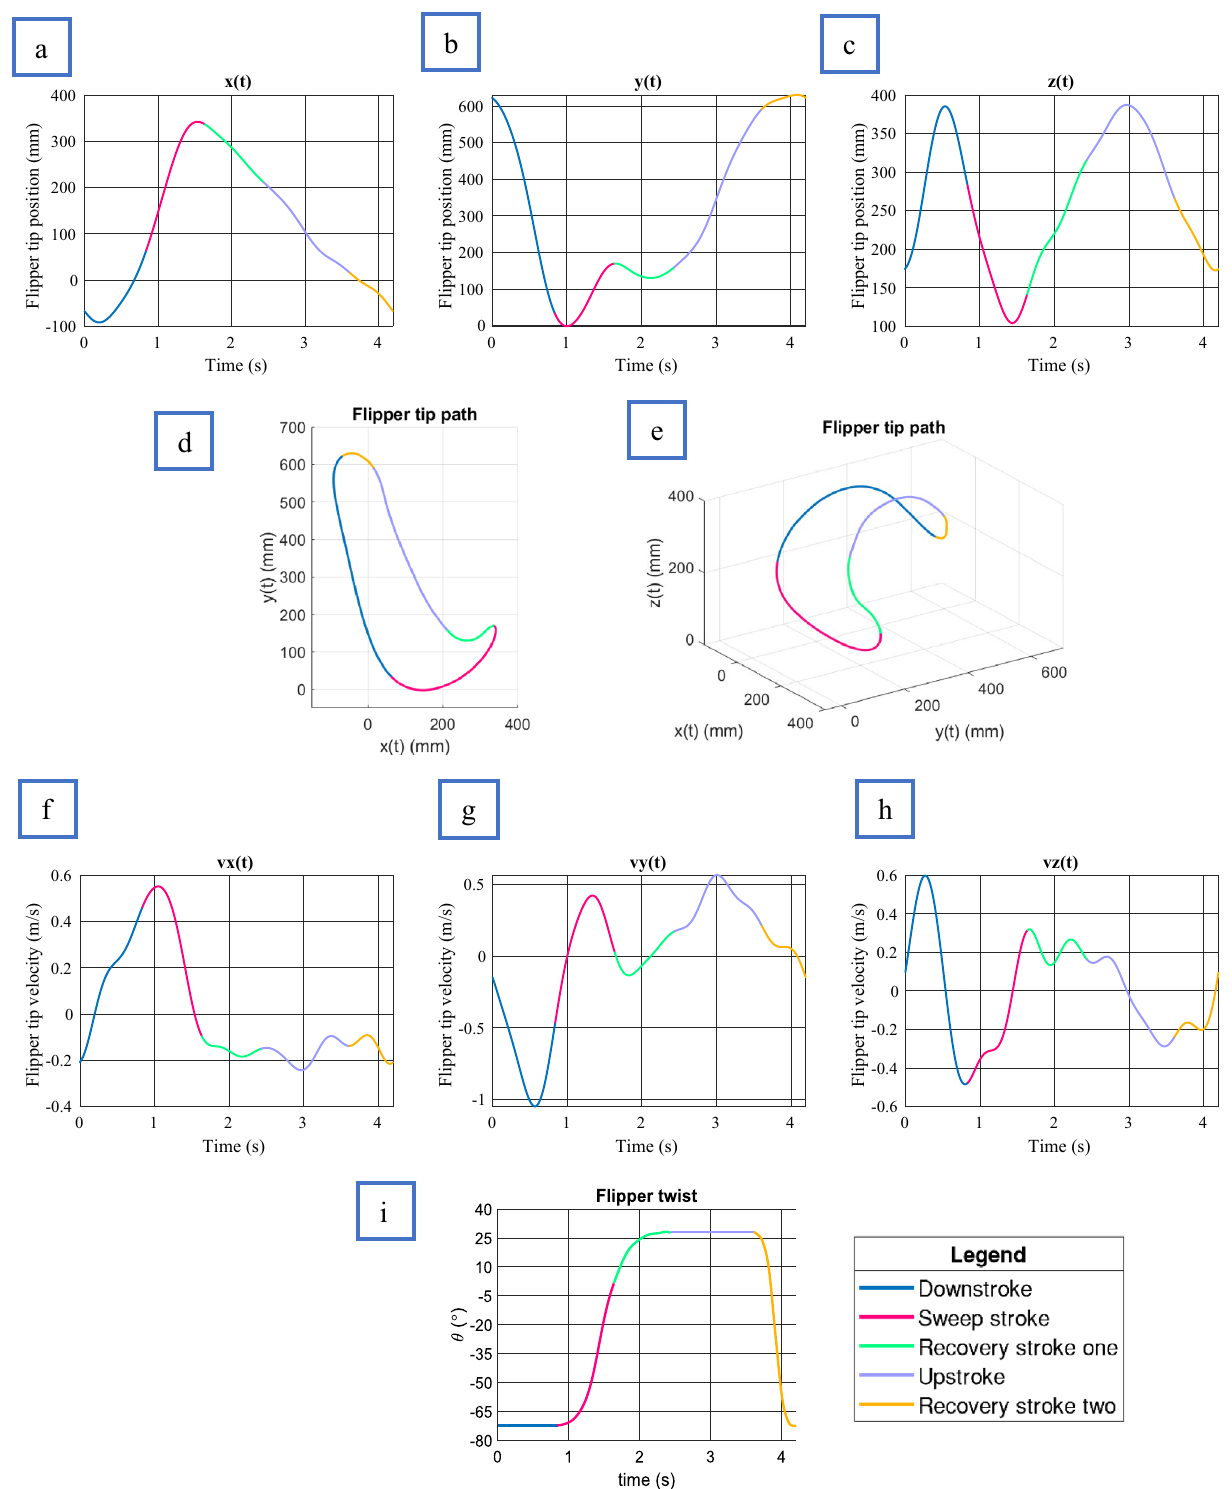
Figure 7. Forelimb flipper kinematics plotted against time. Shoulder rotation point located at ( 92.5, 305, 27.6 ) (mm). All plots represent a turtle of SCL equal to 610 mm. ( a ) Flipper tip position in x, ( b ) Flipper tip position in y, ( c ) Flipper tip position in z, ( d ) Flipper tip path in x, y plane. ( e ) Flipper tip path 3D. ( f ) Flipper tip velocity in x, ( g ) Flipper tip velocity in y, ( h ) Flipper tip velocity in z, ( i ) Flipper